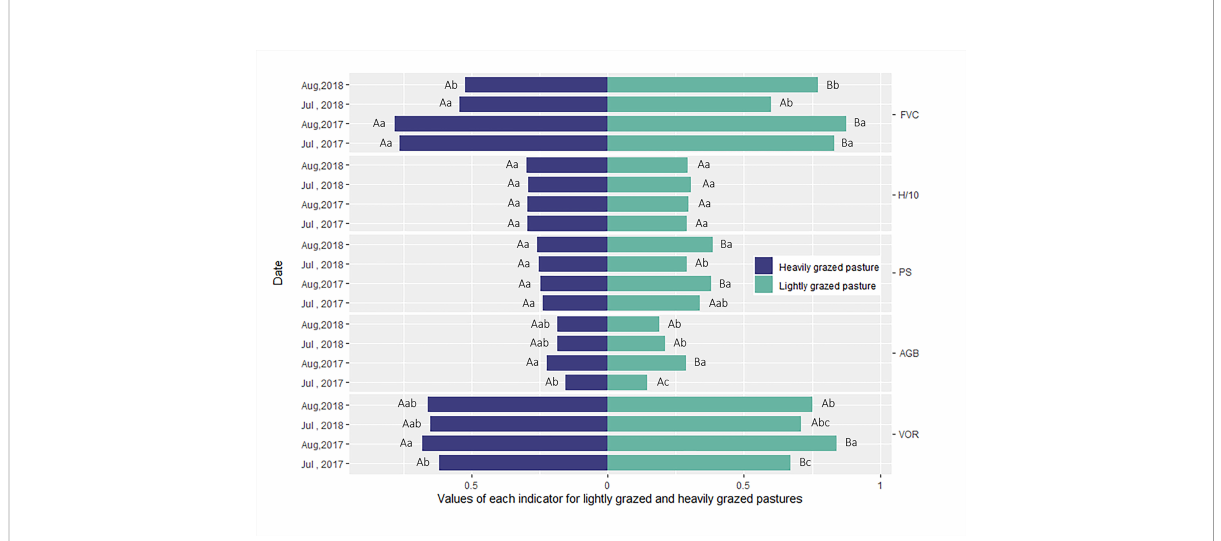
FIGURE 3 Variation in vegetation cover (FVC), species diversity (H), the proportion of palatable species (PS), above-ground biomass (AGB)(kg/m2), and the composite assessment index of grassland health (VOR) between July and August 2017, and July and August 2018, for lightly (L) and heavily (H) grazed pastures. Different lower-case letters (a, b, and c) represent signi fi cant differences in time, and different upper-case letters (A and B) represent signi fi cant differences between lightly and heavily grazed